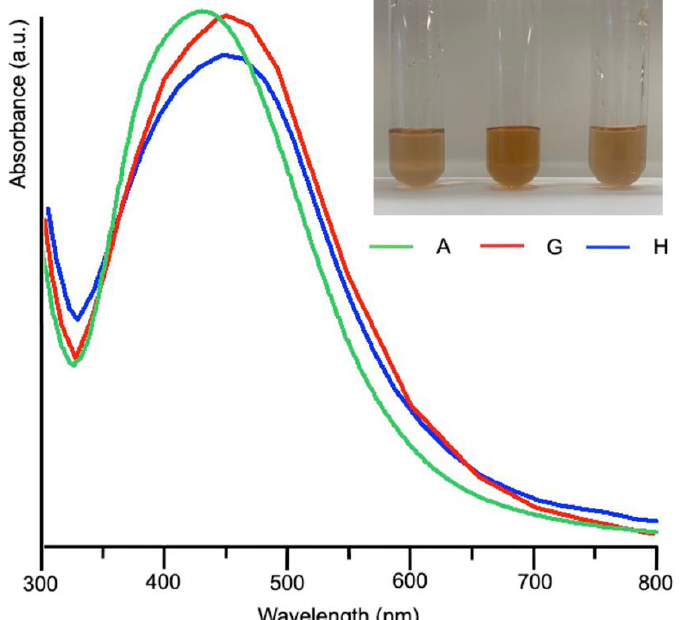
Figure 3. UV-Visible spectra obtained from samples A, G and H after five days from mixing and their relative pictures.